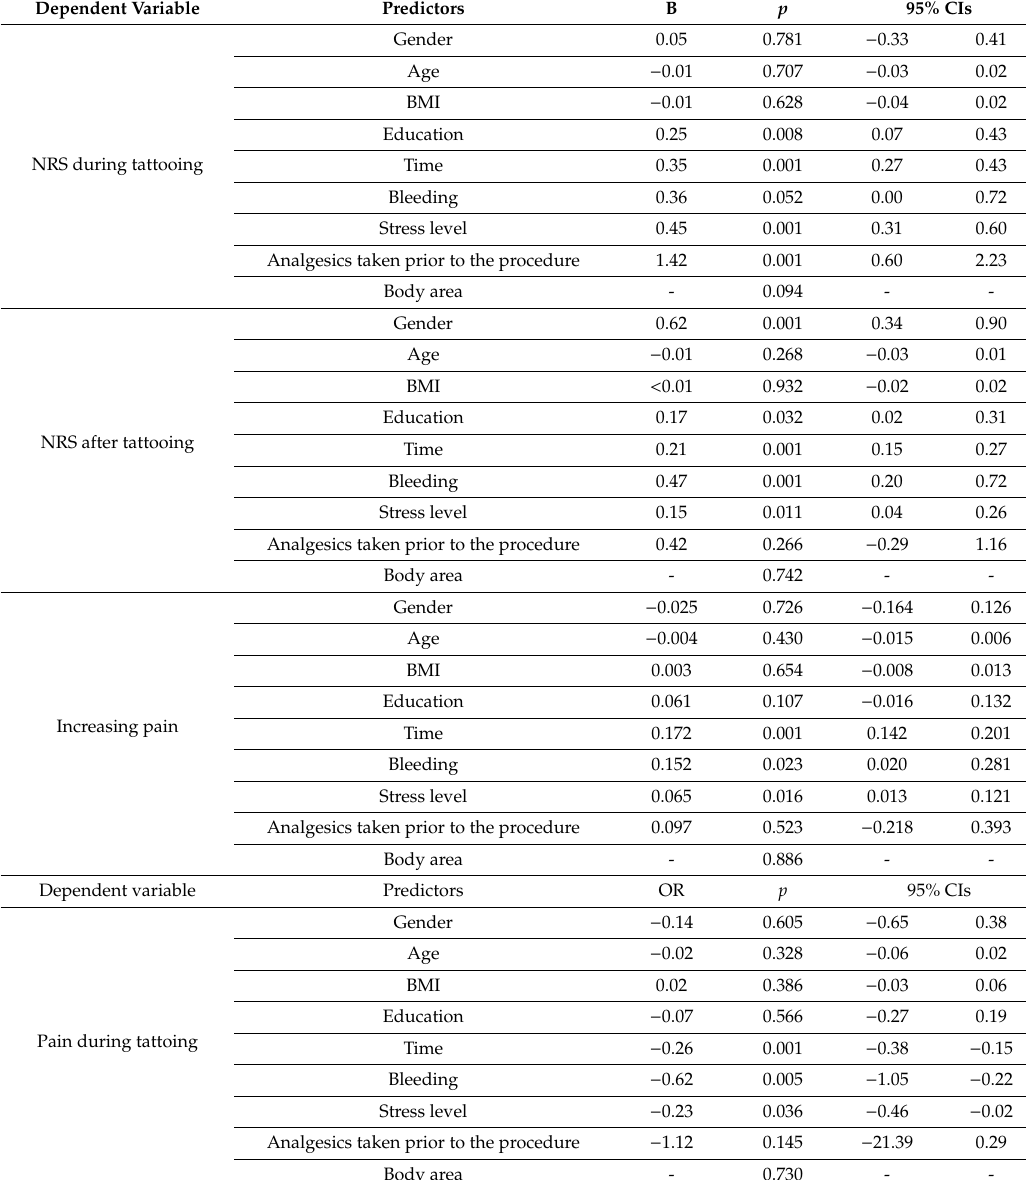
Table 2. Results of regression analyses including gender and excluding cycle